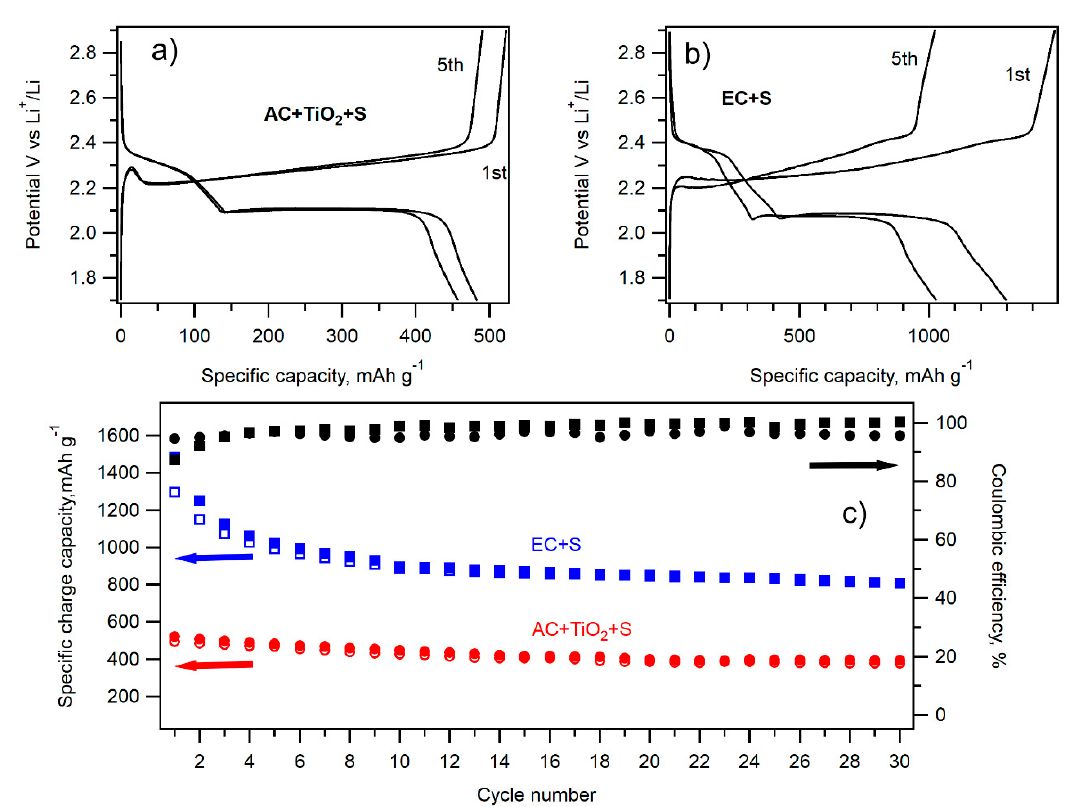
Figure 10. Charge–discharge curves of the 1st and 5th cycle of galvanostatic cycling at 0.1 C of the AC + TiO 2 + S sample ( a ) and EC + S sample ( b ). ( c ) Galvanostatic chronopotentiometry data at 0.1 C of the AC + TiO 2 + S (full red circles charge, open red circles discharge) and EC + S (full blue squares charge and open blue squares discharge) samples. The corresponding Coulombic efficiency values are depicted by full black circles (AC + TiO 2 + S) and full black squares (EC + S).